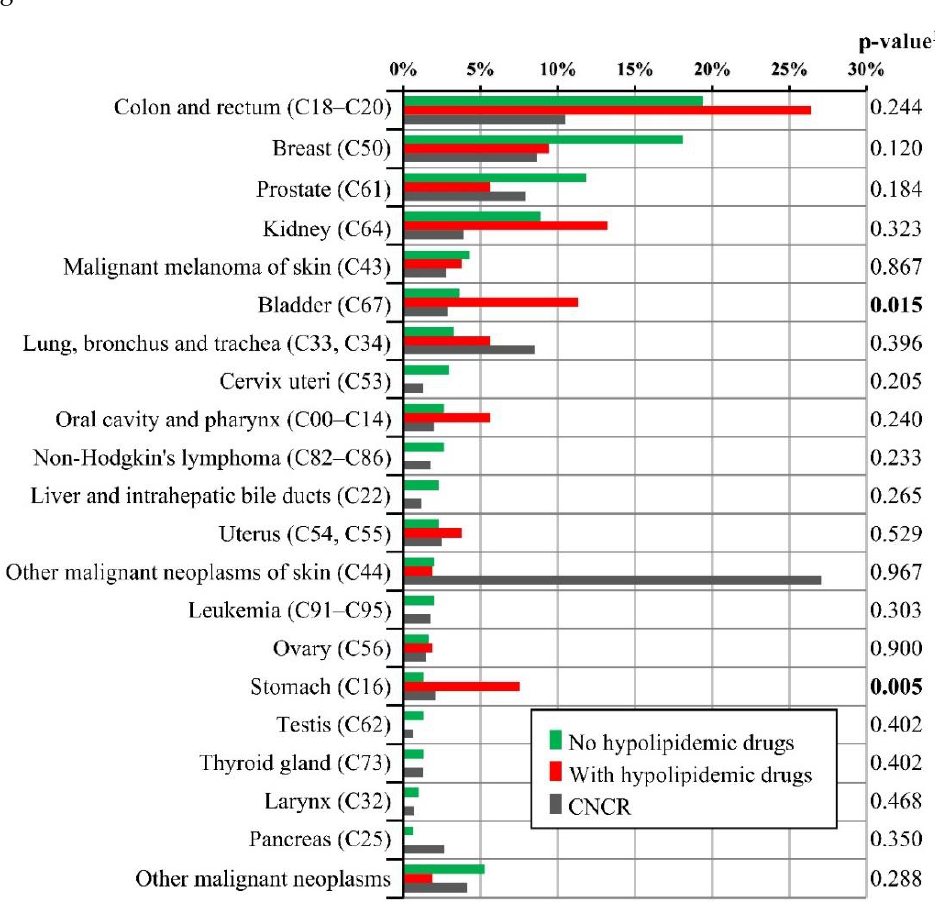
Figure 1. Comparison of the occurrence of second primary malignancies with respect to the use of a hypolipidemic drug. ( 1 p -value of N-1 Chi-squared test for the group of nonhypolipidemic users and the group of patients with hypolipidemic drugs. CNCR, Czech National Cancer Registry).